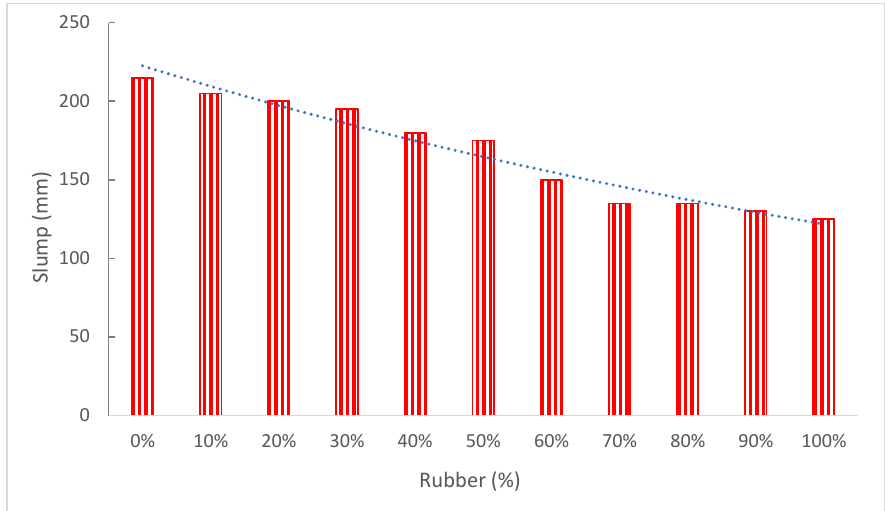
Figure 4. Slump flow: data source [30]. Table 1. Summary of slump flow.